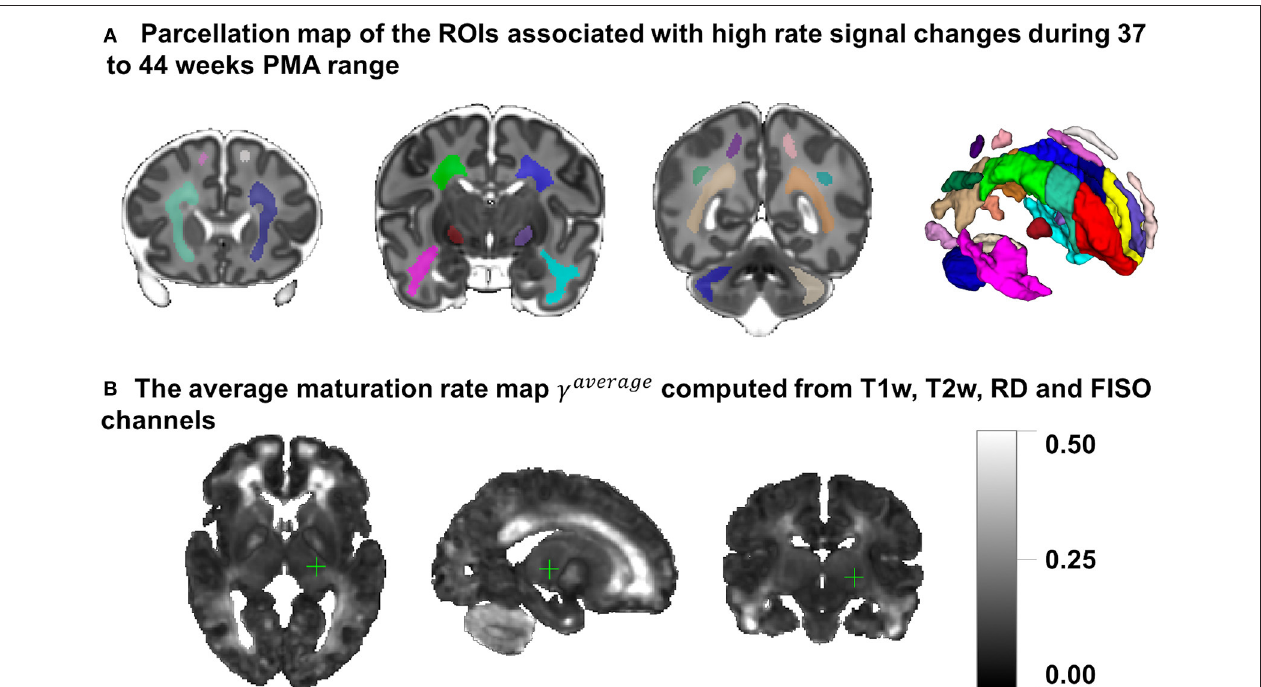
FIGURE 8 | (A) The parcellation map of 24 paired regions identified by high change rates during 37–44 week PMA. (B) The average maturation rate map γ av computed from T1w, T2w, RD, and FISO channels.